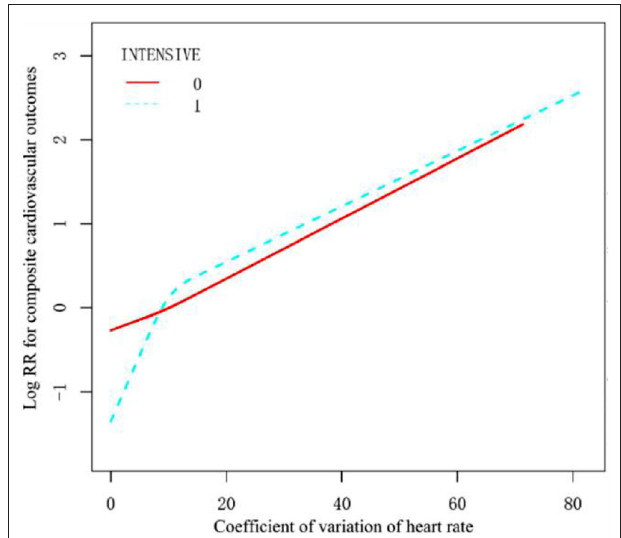
FIGURE 3 | Smooth spline curves of visit-to-visit heart rate variability for the estimation of risk of composite cardiovascular outcomes stratified by treatment arms. The red solid line (INTENSIVE 0) is standard, and the blue dotted (INTENSIVE 1) line is intensive BP control. All covariables in Model 3 except treatment arms were